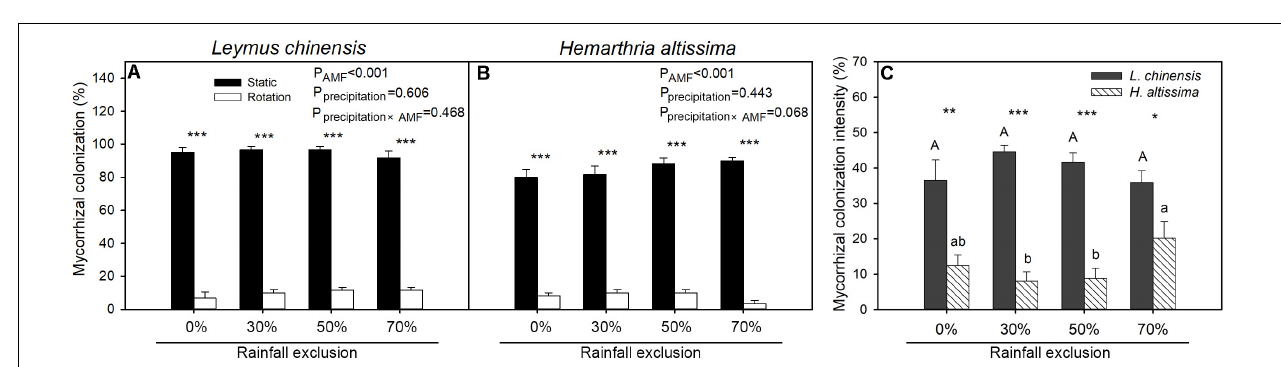
FIGURE 3 | The percentage of arbuscular mycorrhizal fungi (AMF) roots colonization (F%) in L. chinensis (A) and H. altissima (B) , and the intensity of mycorrhizal colonization (M%) (C) . Different lowercase and capital letters indicate significant differences ( P < 0.05) among the rainfall exclusion treatments in H. altissima and L. chinensis , respectively. ∗∗∗ P < 0.001, ∗∗ P < 0.01, and ∗ P < 0.05 indicates differences between L. chinensis and H. altissima . Data are reported as mean ± 1 SE ( n = 4).